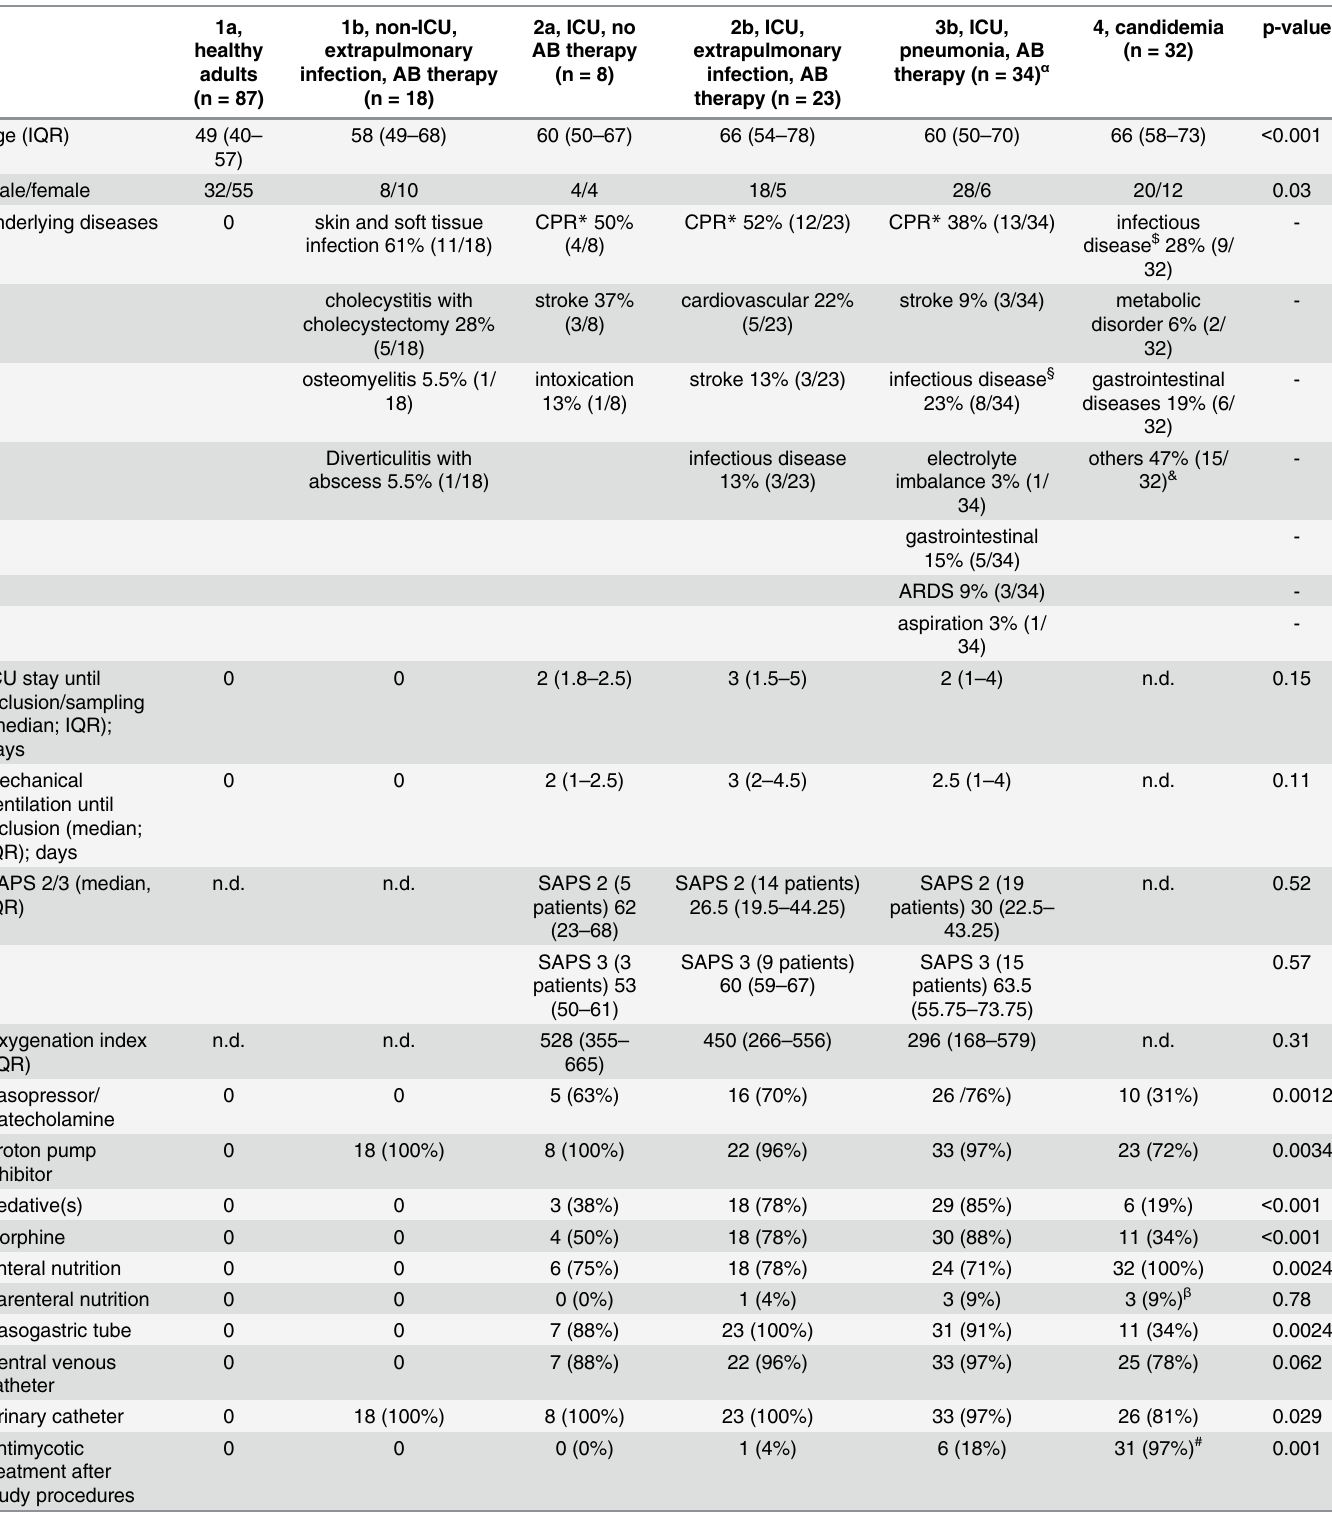
Table 1. Demographic data and clinical characteristics of study patients. ICU patients were all intubated and mechanically